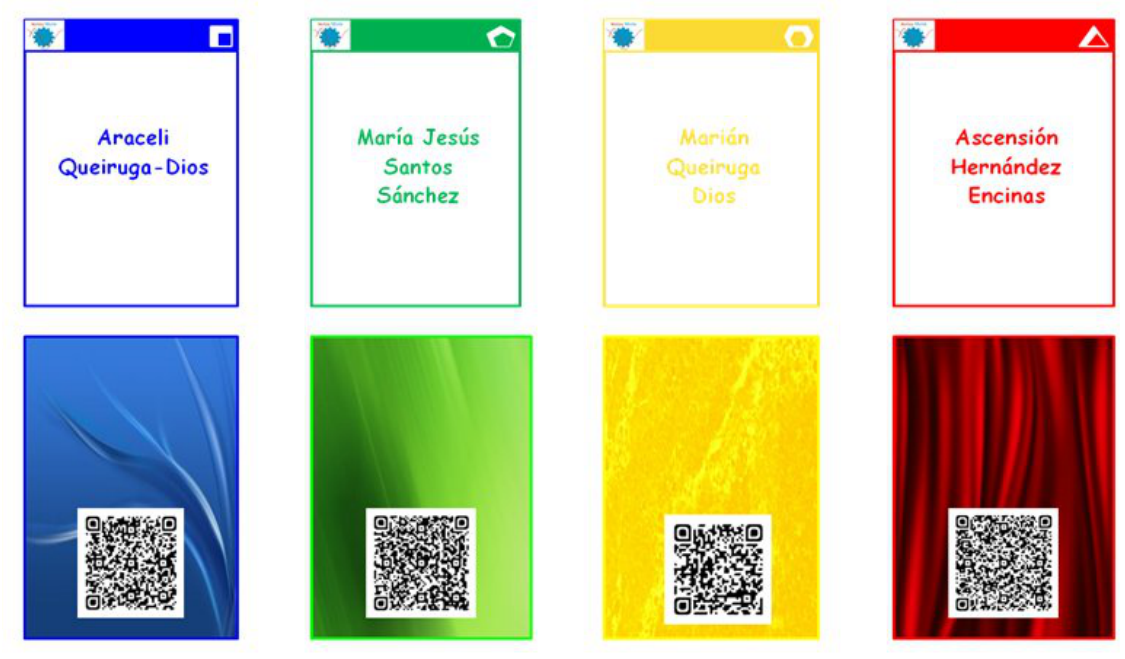
Figure 1. Gamers’ identification